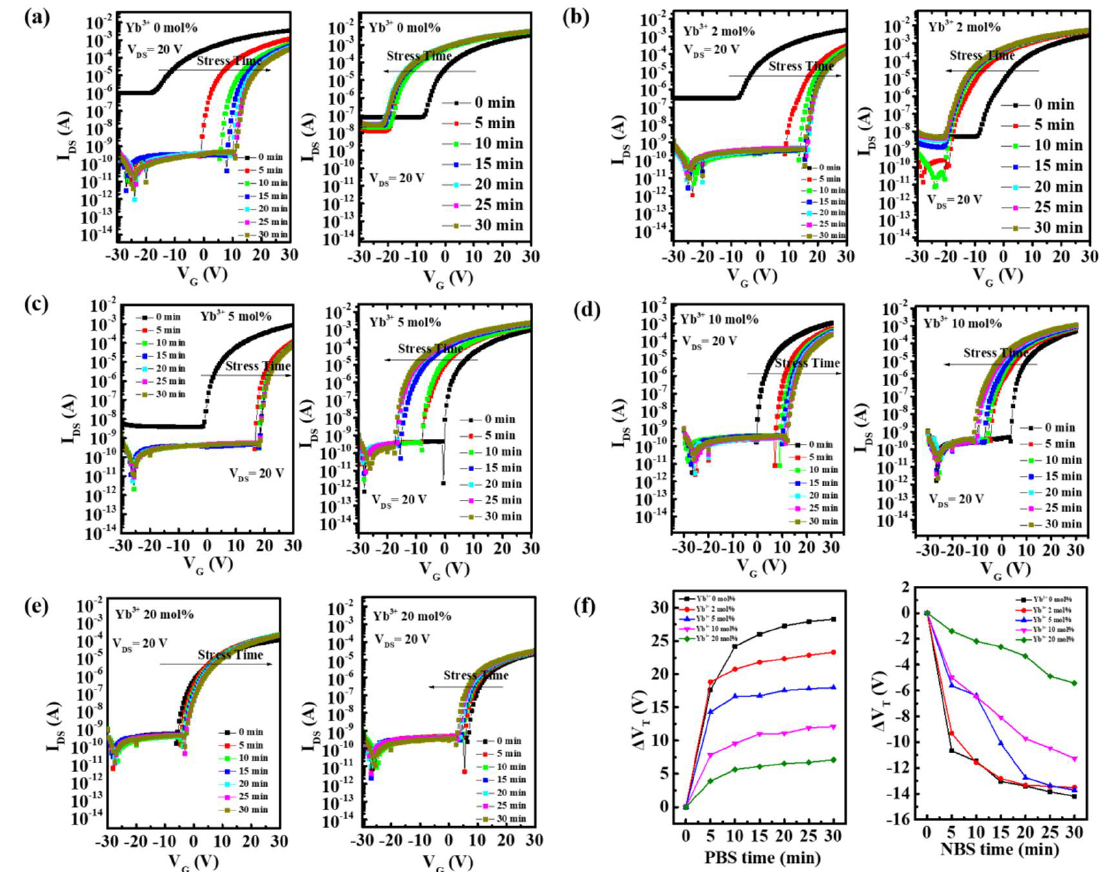
Figure 10. Transfer curves variations under PBS and NBS of In-Yb-O TFTs with Yb ratios of: ( a ) 0%, ( b ) 2%, ( c ) 5%, ( d ) 10%, and ( e ) 20%. ( f ) Summary of V th shifts under PBS and NBS.